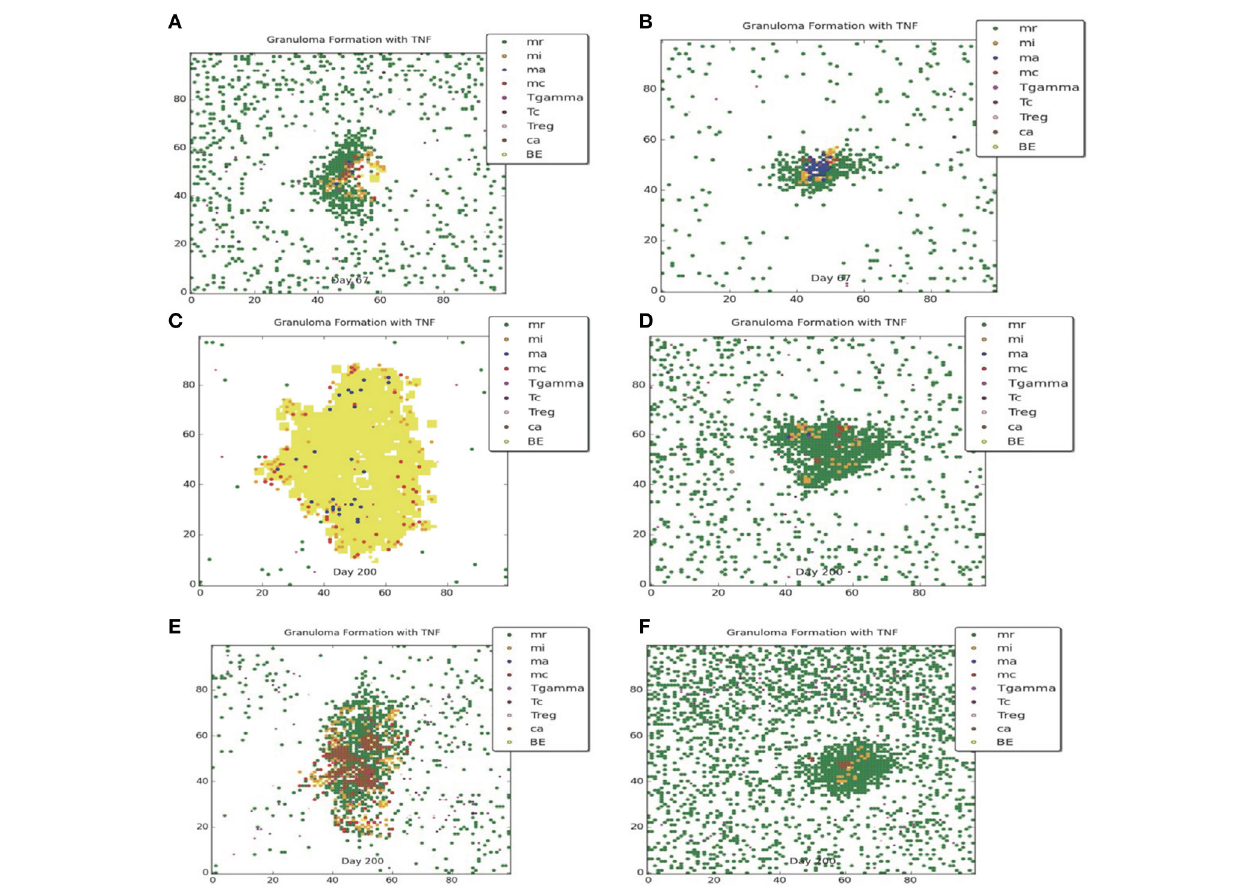
FIGURE 3 | Comparison of transient containment outcomes at 67 days post infection (A,B) and 200 days post infection; the standard re-implemented model (ABM-ST) results in dissemination (C) and the physiologically-based model (ABM-PHYS) results in a loosely packed containment (D). True